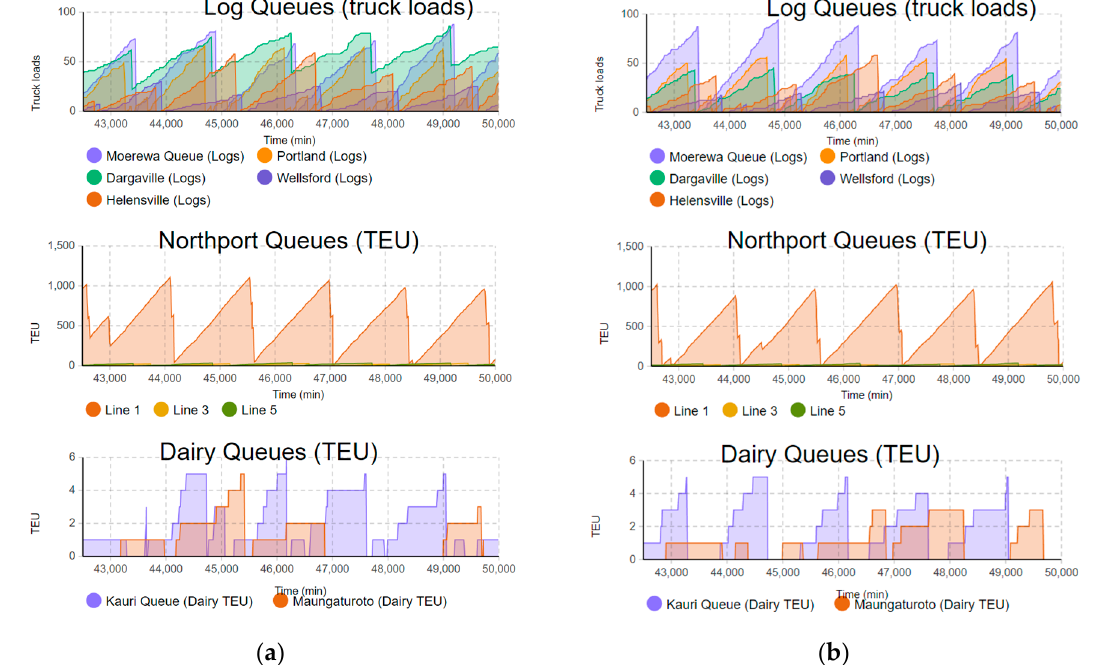
Figure 12. Queues at different terminals: ( a ) Experiment 2; ( b ) Experiment 6.